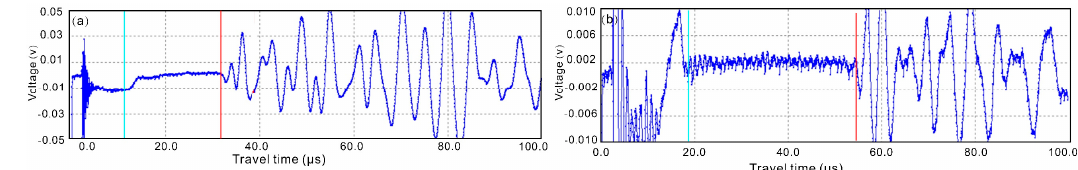
Figure 12. Determination of travel time for the P and S-waves from the waveforms. ( a ) Determination of P-wave travel time from the first wave cycle; ( b ) determination of S-wave travel time from the first wave cycle.